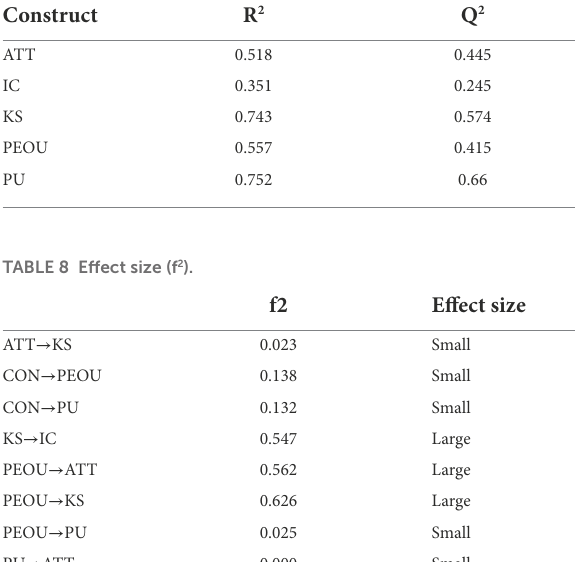
TABLE 7 Predictive accuracy.